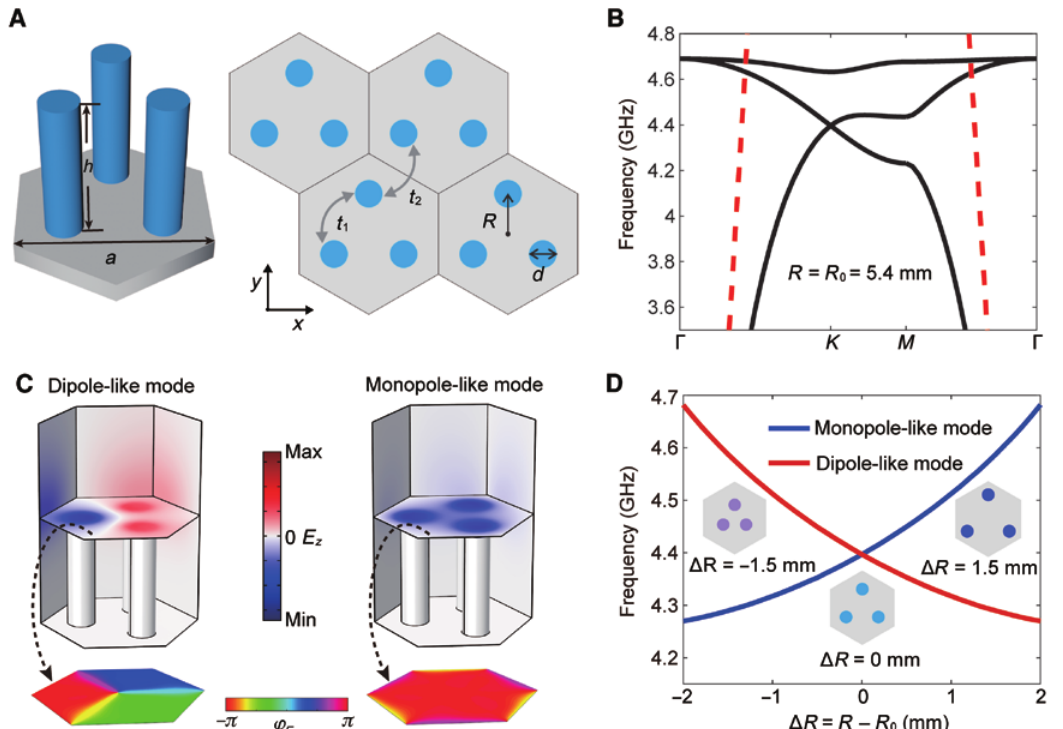
Figure 1: Bulk band structure of the Kagome PC and topological phase transition. (A) The unit cell of the Kagome PC (left) consists of three aluminum rods standing on a metallic substrate (gray). The lattice constant a is 18.7 mm and the height of aluminum rod h is 14 mm. In the top view of the PC (right), the rod diameter d is 3.7 mm and R denotes the distance between the unit cell center and the neighboring aluminum rod. Parameters t interactions, respectively. (B) Bulk band structure of the PC when R = R bulk states at K are composed of dipole- and monopole-like modes, whose E 1 mm above the aluminum rod and at three vertical sides of the unit cell. Bottom: phase lowest bulk states at the K point when Δ R ( = R – R phase transition. The insets show the top view of the unit cell with corresponding Δ R values labeled below. Here, we use different colors of rods to distinguish PCs with different Δ R